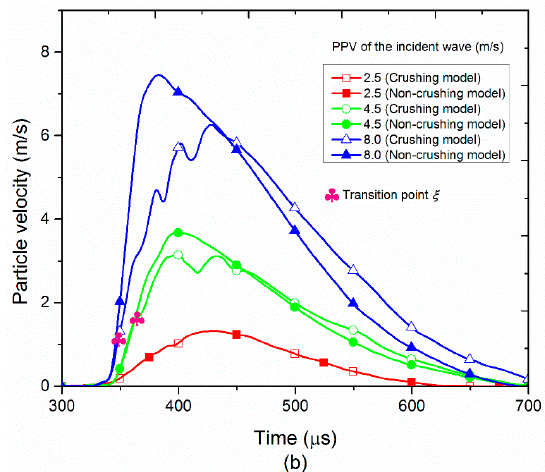
Figure 4. ( a ) Incident waves with different PPVs; ( b ) Corresponding transmitted waves obtained by